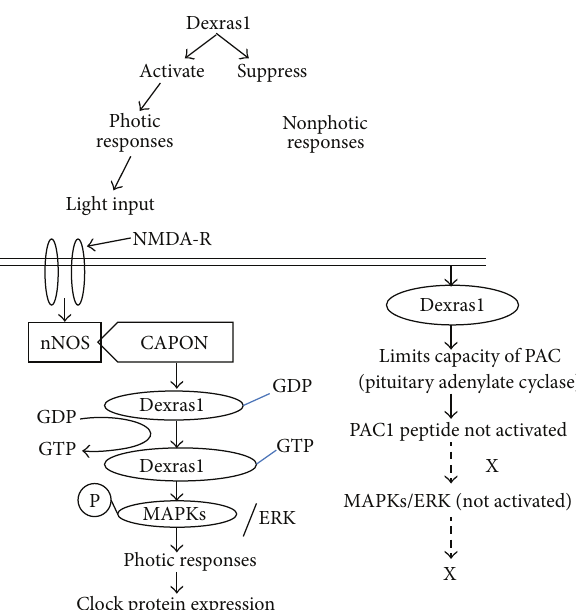
Figure 5: Dexras1 activates photic response and suppresses non- photic response. Dexras1 activate the photic response by sig- nalling pathways that regulate extracellular signal-regulated kinase (ERK)/mitogen-activatedproteinkinase(MAPK).Theternarycom- plex (nNOS, CAPON, and Dexras1 bound to GDP) receives an external signal of light through NMDA receptor and leads to S- nitrosylation of Dexras1 on cysteine 11, an apparent prerequisite for GTP binding by which it becomes active to produce downstream signalling and produce photic response. In absence of external signal, light input, Dexras1 suppresses the nonphotic response by limiting the capacity of Pituitary Adenylate Cyclase (PAC so PAC1) to get activated; hence MAPKs/ERK is not activated and photic response not produced.